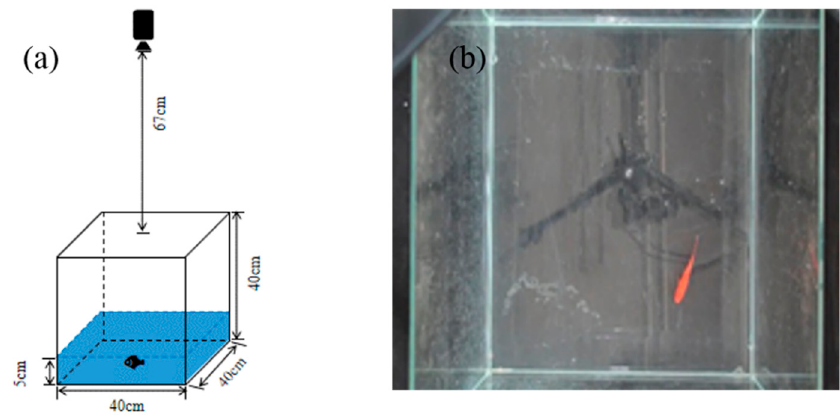
Figure 1. Experimental device. ( a ) schematic diagram of the experimental device, ( b ) actual shooting effect.